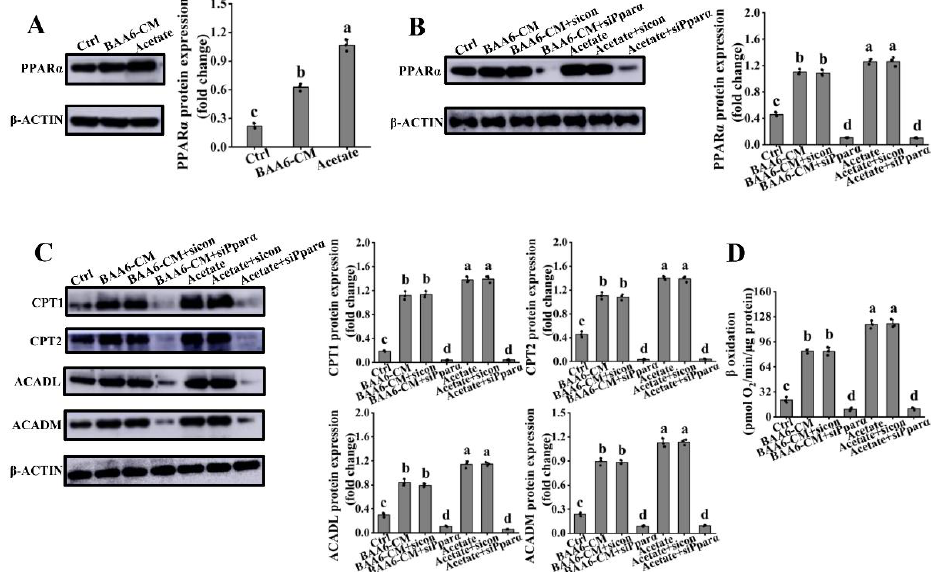
Figure 5. Effect of acetate or BAA6-CM on peroxisomal proliferator-activated receptor α (PPARα) signaling in 3T3-L1 cells. ( A ) Protein expression levels of PPARα after treatment with 4% BAA6-CM or 23.96 mmol/L acetate for 3 days. Levels of protein expression of ( B ) PPARα, and ( C ) CPT1, CPT2, ACADL, and ACADM after cell treated with control or PPARα-special small interfering RNA (siRNA), followed by addition of 4% BAA6-CM or 23.96 mmol/L acetate for 3 days. ( D ) β oxidation, measured by Seahorse XF platform after cell treatment, with control or PPARα-special siRNA, fol- lowed by addition of 4% BAA6-CM or 23.96 mmol/L acetate for 3 days. Values are shown as means ± SD. Different lowercase letters mean remarkable differences between groups at p < 0.05.